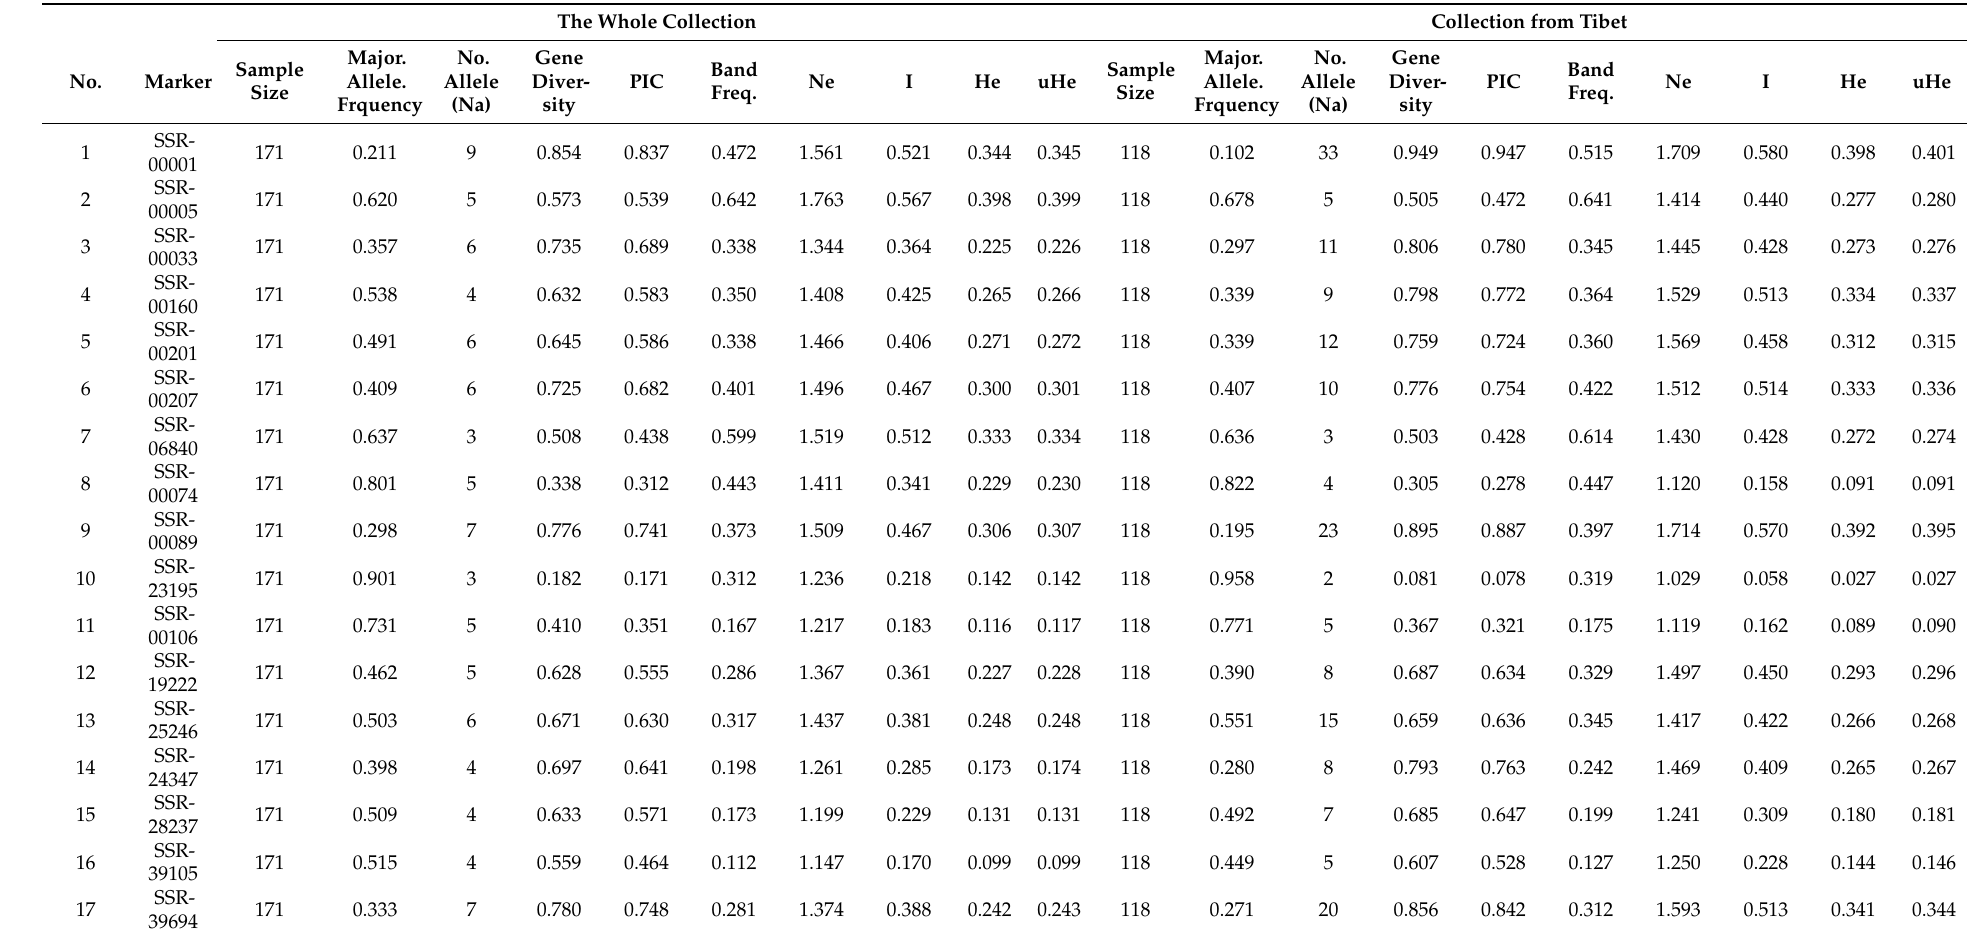
Table 1. Genetic diversity information list of 31 SSR primers used in the